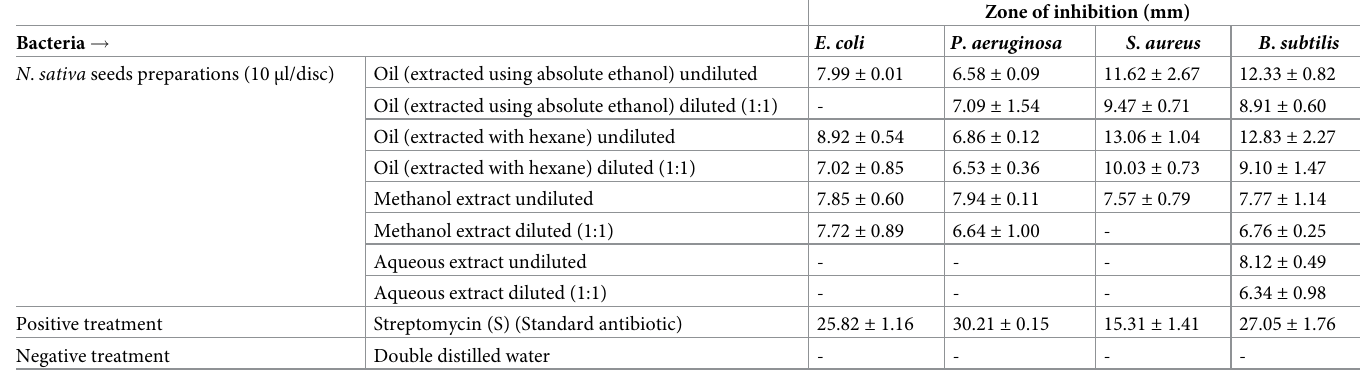
Interpretation of results:—(-) implies no zone of inhibition observed The values are expressed as mean ± SD of the three replicates Significant at p <